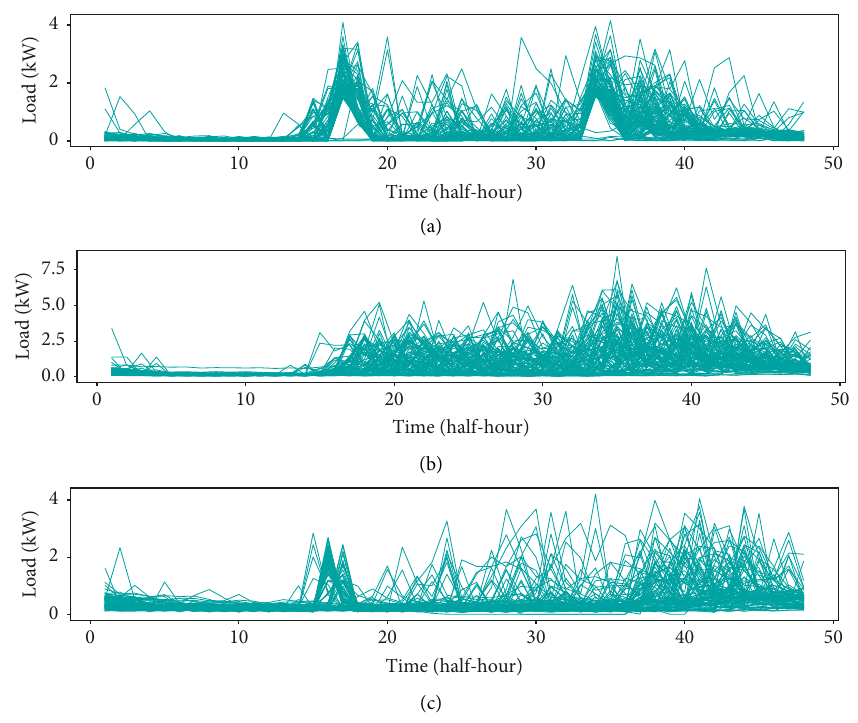
Figure 2: Different residential load patterns. (a) Meter ID: 5843. (b) Meter ID: 6902. (c) Meter ID: